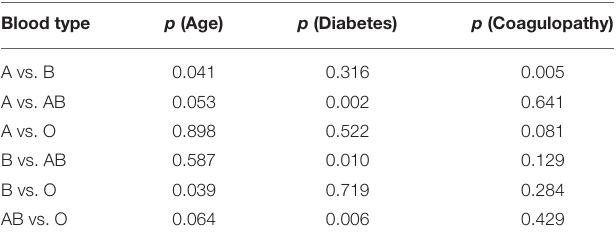
TABLE 2 | Comparisons of age, diabetes, and coagulopathy between different blood